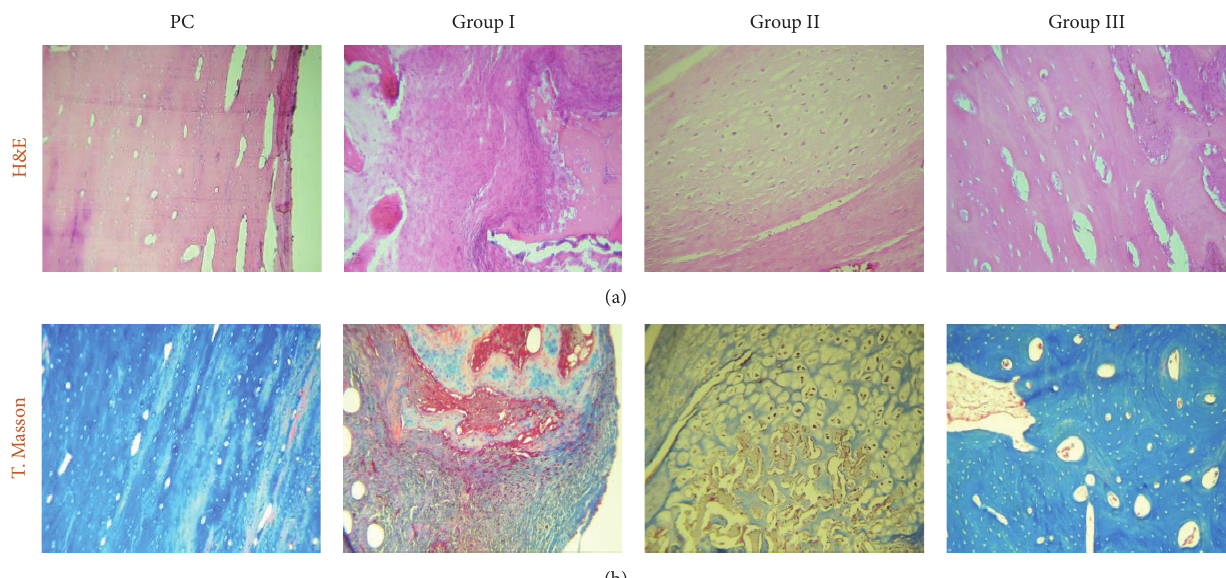
Figure 5: Postmortem histological staining. (a) H&E; (b) Masson’s trichrome. PC: positive control. Micrographs with 10x amplification.